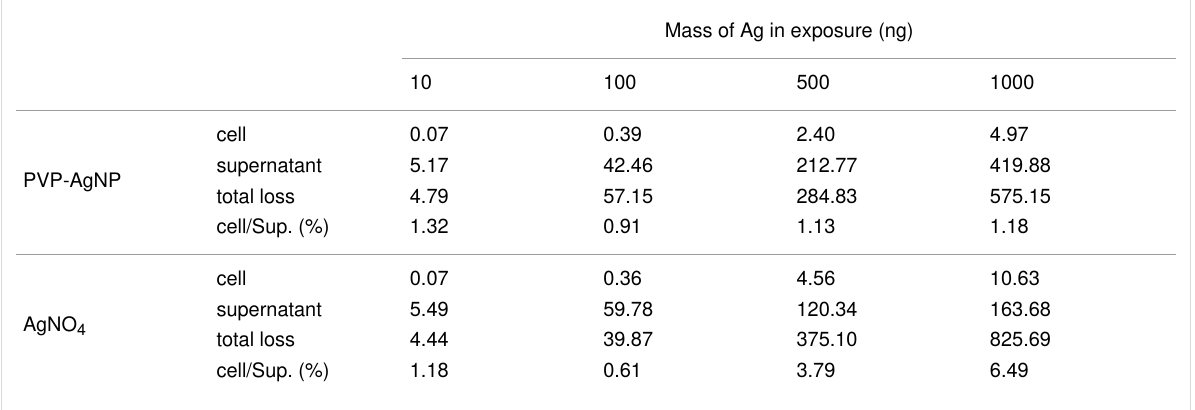
Table 2: Mass balance of Ag. Ag mass balance (in the supernatant and cells) after AgNP and AgNO 3 treatment measured by ICP-MS. Cell data were collected after three washes with PBS and shows internalized and strongly bound Ag. Total loss indicates losing some Ag during washes or experi- mental process. Ratio between uptake in cells and in supernatant in percent for Ag.